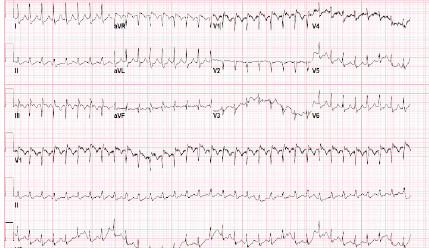
Figure 3: Electrocardiogram showing supraventricular tachycardia and the S1Q3T3 pattern (deep S waves in lead I and Q waves and T wave inversion in lead